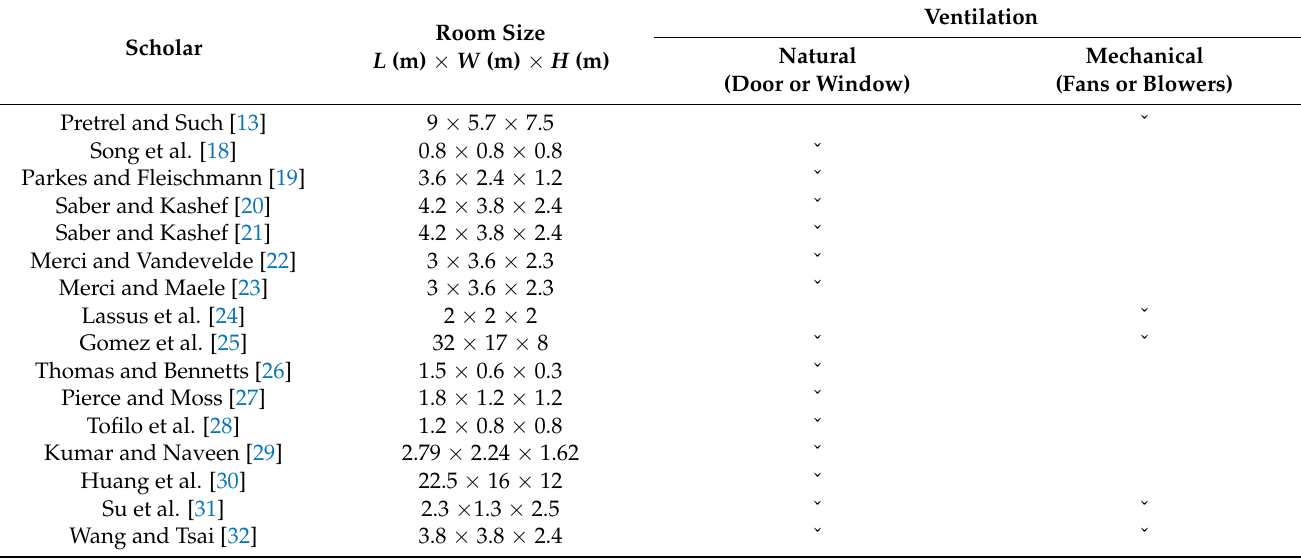
Table 1. Studies related to the effect of natural or mechanical ventilation changes on fire